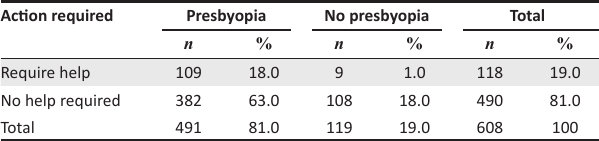
TABLE 3: Those requiring help from others because of near-vision problems.